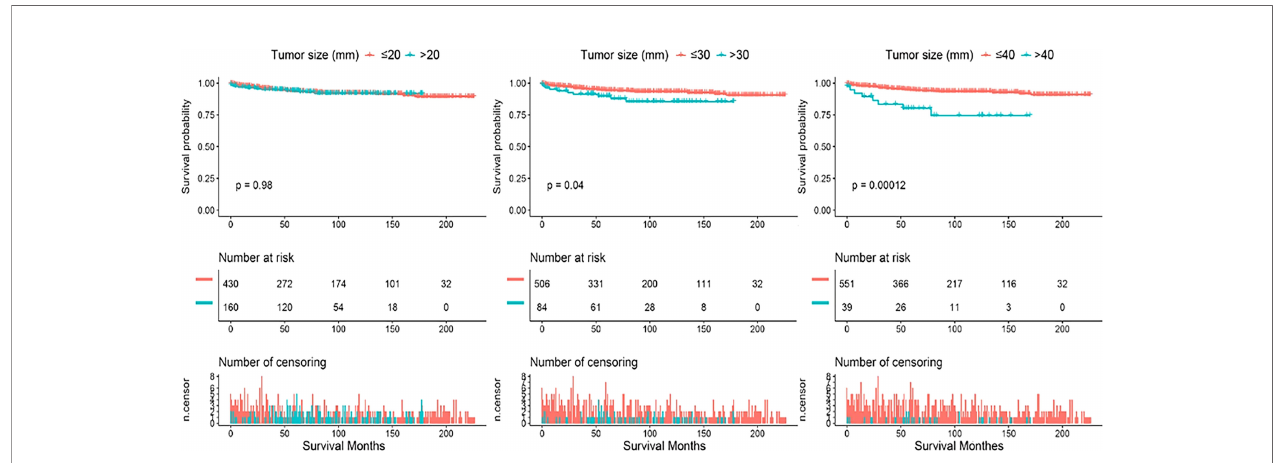
FIGURE 3 | Kaplan-Meier survival curves demonstrating survival disparity of cancer-speci fi c survival by categorizing the parathyroid carcinoma population using different tumor size cutoffs. Cancer-speci fi c survival of PC patients was not signi fi cantly different between tumor diameter larger and small than 2 cm (Log-rank test, P=0.98) group. Yet, the cancer speci fi c survival difference became statistically signi fi cant when dividing the PC cohort between tumor diameter cutoffs at 3 cm (Log- rank test P = 0.04) and 4 cm (Log-rank test P < 0.001).